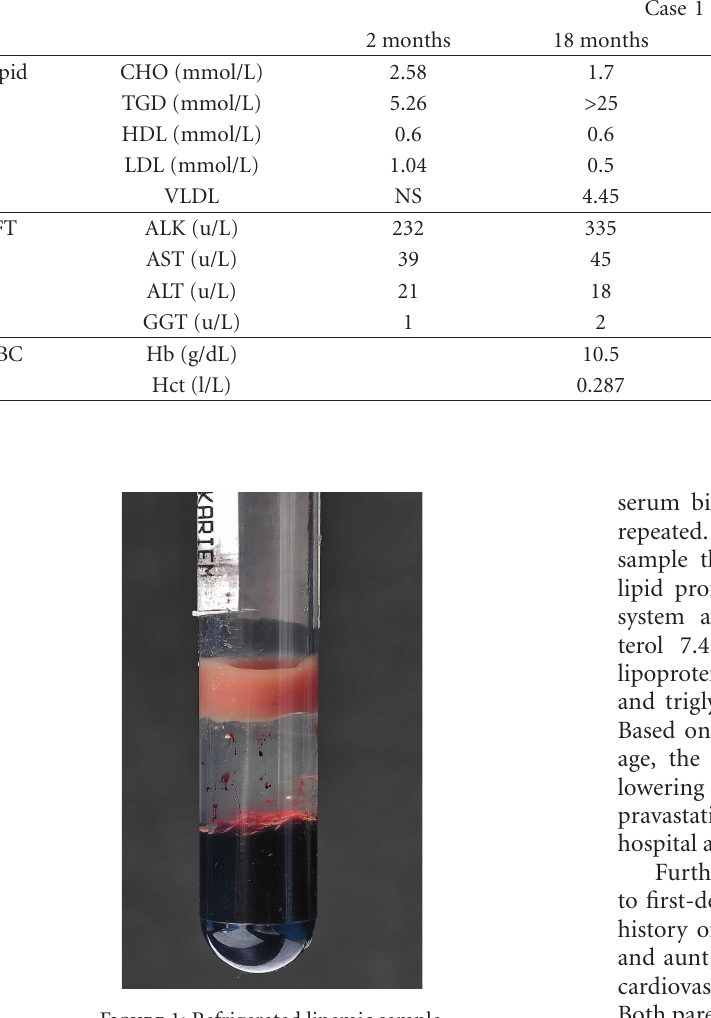
Figure 1: Refrigerated lipemic